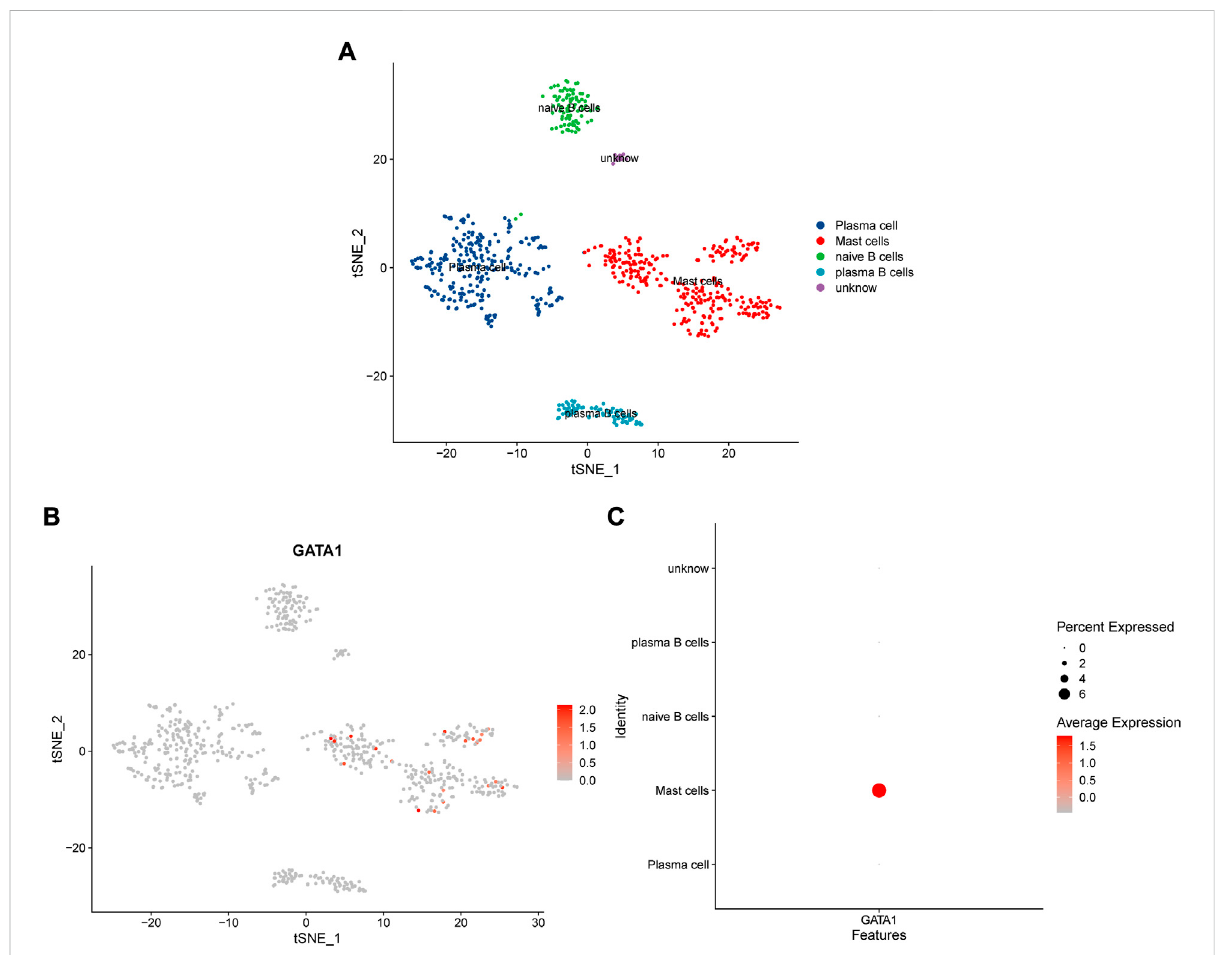
FIGURE 9 Expression relationship of GATA1 in cell grouping of Plasma B and mast cells; (A) Further clustering of Plasma B and mast cells into different subgroups; (B,C) Expression of GATA1 in different subgroups of Plasma B and mast